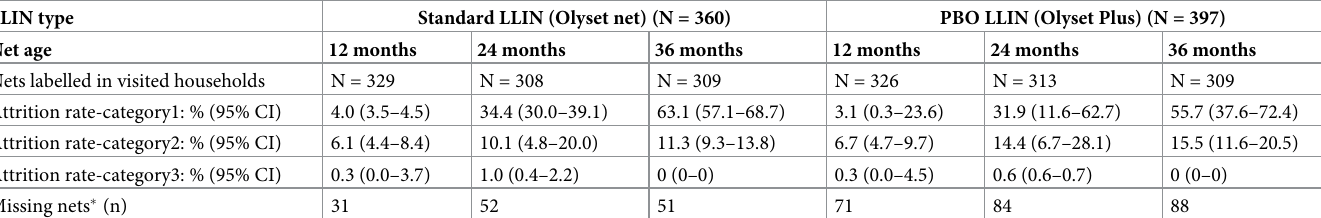
Table 3. Survivorship and attrition of cohort nets by net type and age (data from longitudinal survey). LLIN